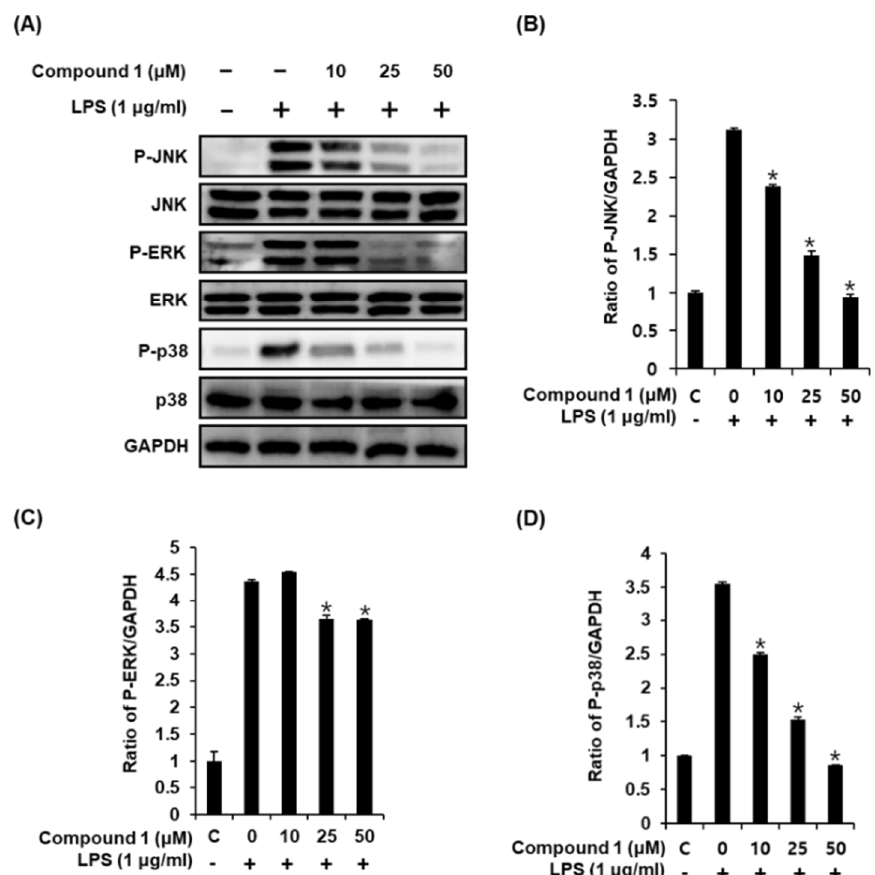
Figure 4. Effects of compound 1 on the LPS-induced expression of MAPKs (JNK, ERK, and p38) in RAW 264.7 mouse macrophages. ( A ) Representative western blots for JNK, ERK, p38, and GAPDH protein expression. ( B ) Quantitative graph for P-JNK. ( C ) Quantitative graph for P-ERK. ( D ) Quantitative graph for P-p38 (mean ± SD, * p < 0.05 as compared with the LPS-treated group).